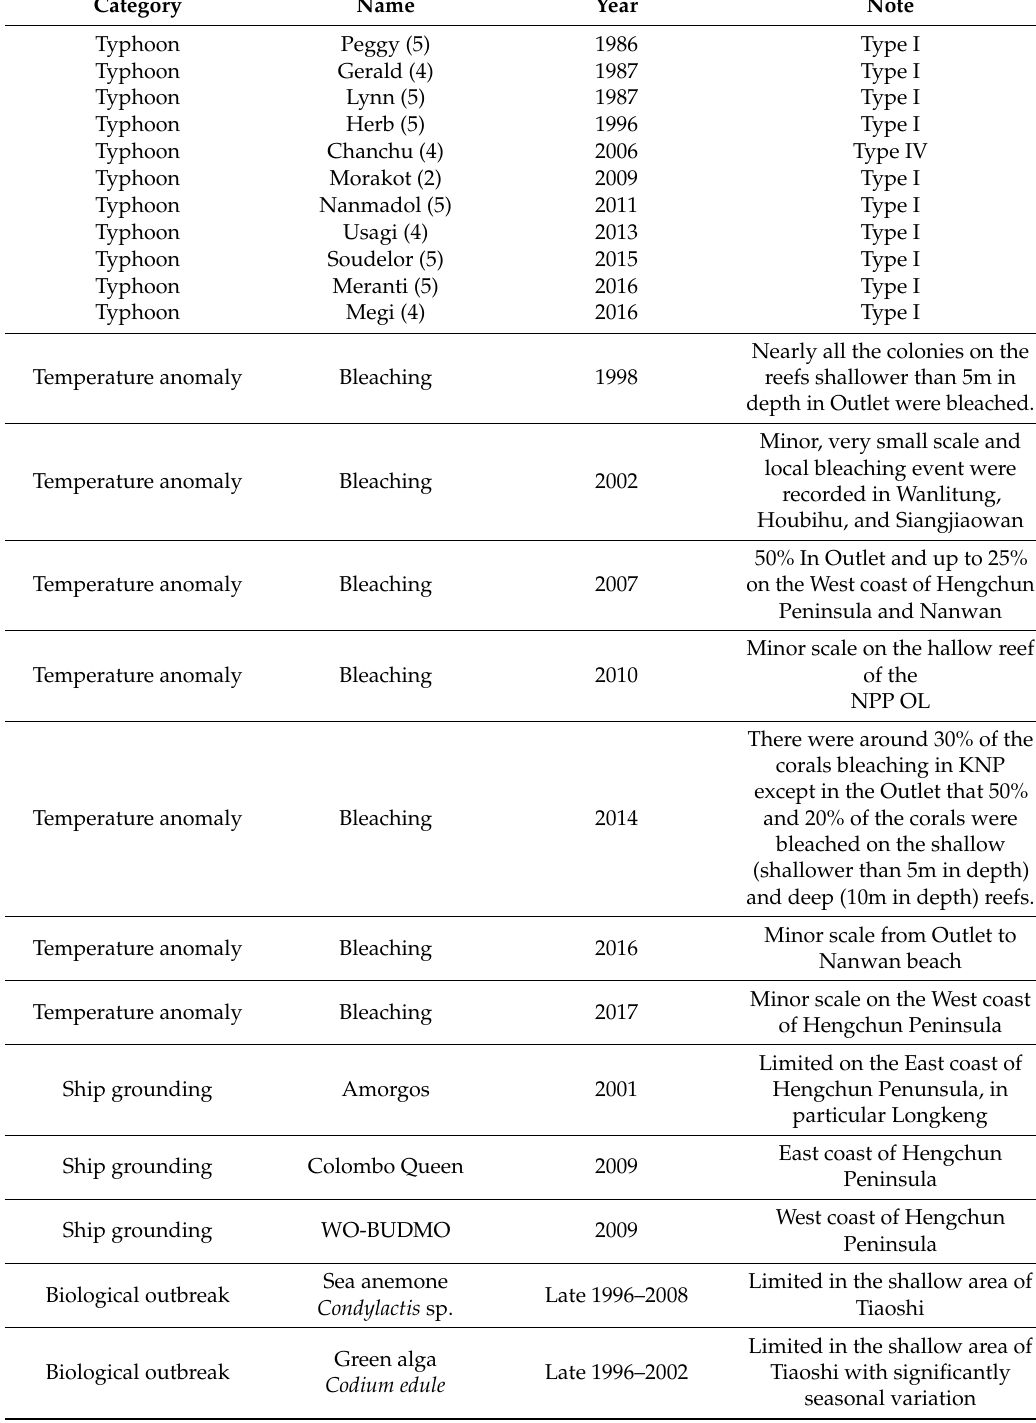
Table 3. Summary of the historical disturbances, typhoons, coral bleaching events, and biological outbreaks in Kenting National Park since 1986. Type I and IV of typhoons referred the direction of typhoon used in Figure 4. Typhoon categories are inside the brackets after typhoon